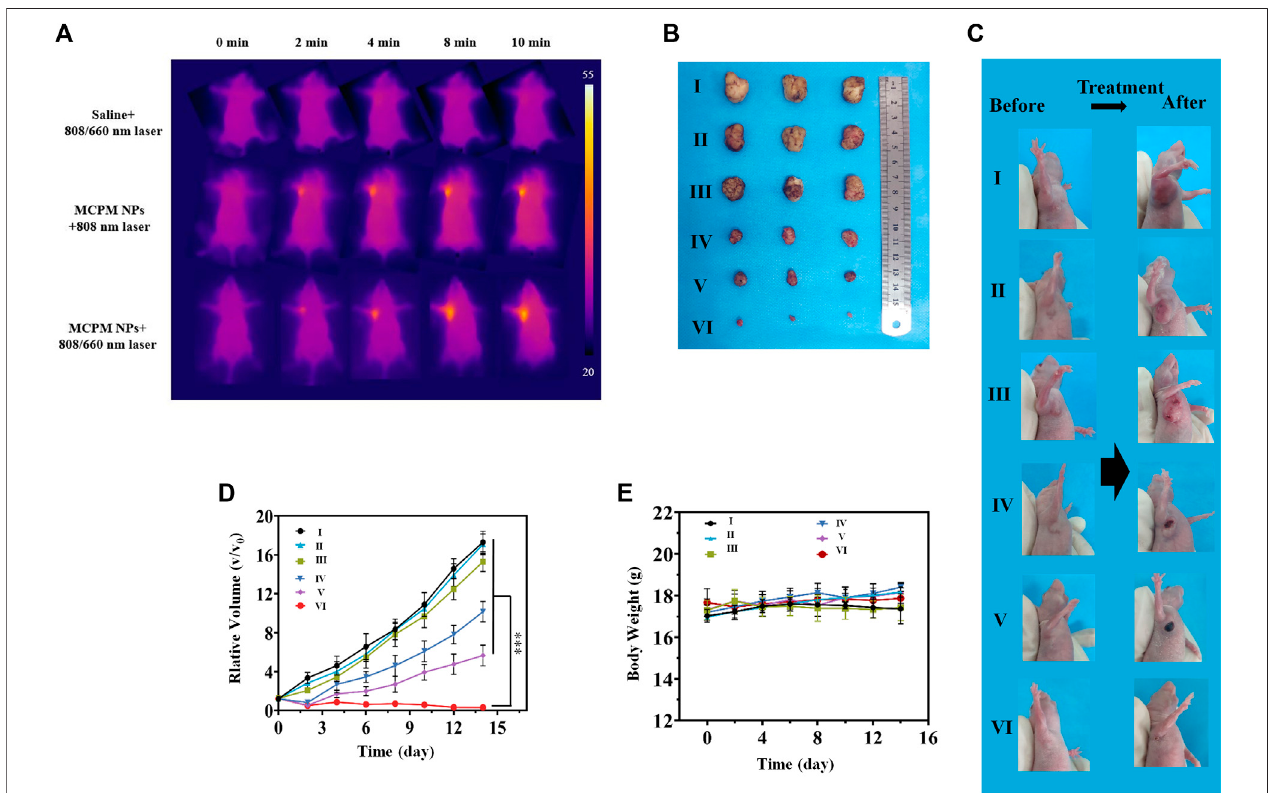
FIGURE8 | Invivo PTT-PDTperformance. (A) Thermal images ofthe MDA-MB-231 tumor model mice upon different treatments. (B) Photographs oftumors from different treatment groups. Average tumor weight after different treatment. (C) Photographs of mice with subcutaneous MDA-MB-231 tumor following different regimens. (D) Changecurvesofrelativetumorsizes.*** p < 0.001. (E) ChangecurvesofbodyweightofmicewithMDA-MB-231tumorfollowingdifferentregimens.Data areshownasmean ± SD,( n (cid:2) 3),(GroupsI-VIaredesignatedassaline,MCPMNPs,saline+808/660 nmlaser,MCPMNPs+808 nmlaser,MCPMNPs+660 nm laser, and MCPM NPs + 808/660 nm laser groups,